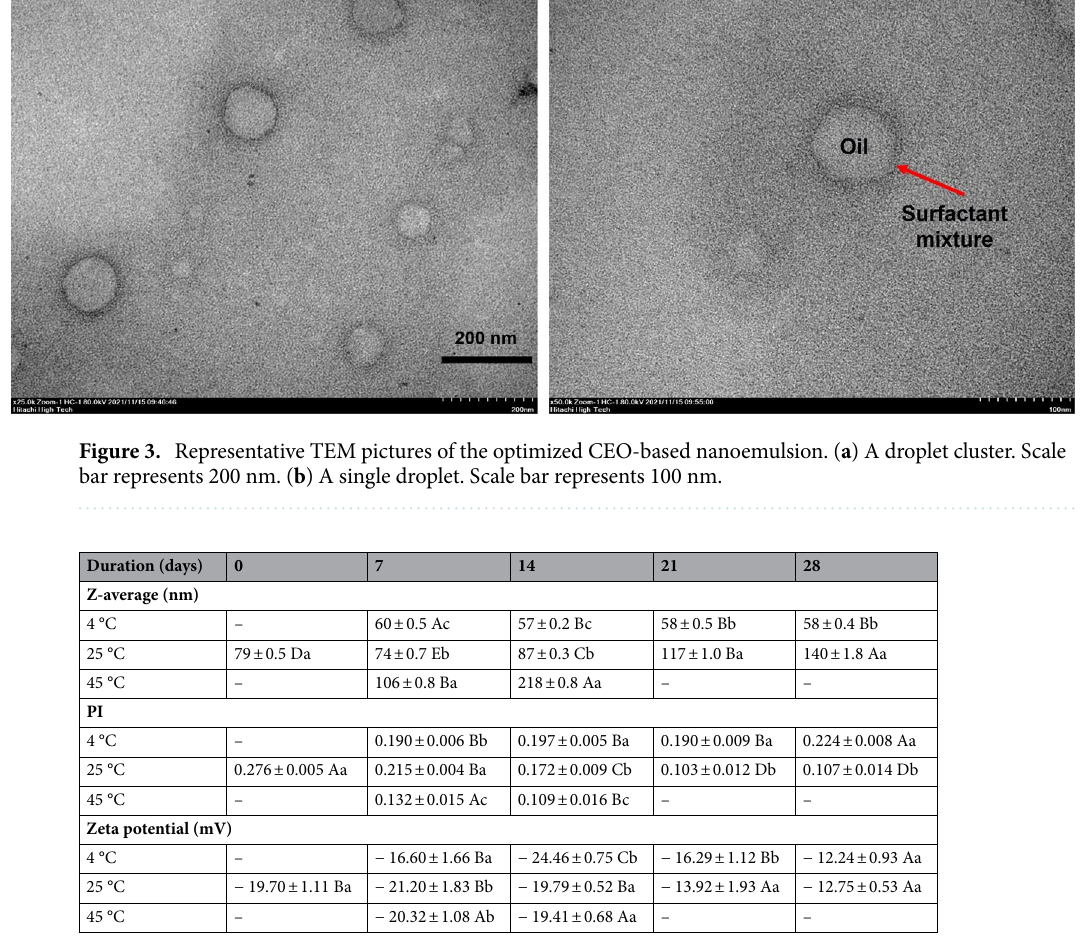
Table 5. The effect of storage temperature and duration on Z-average (particle diameter), PI, and zeta potential of CEO-based nanoemulsions. Means ± standard deviations. Means with different uppercase letters are significantly different ( p < 0.05) within the row. Means with different lowercase letters are significantly different ( p < 0.05) within the column (same parameter and day for different